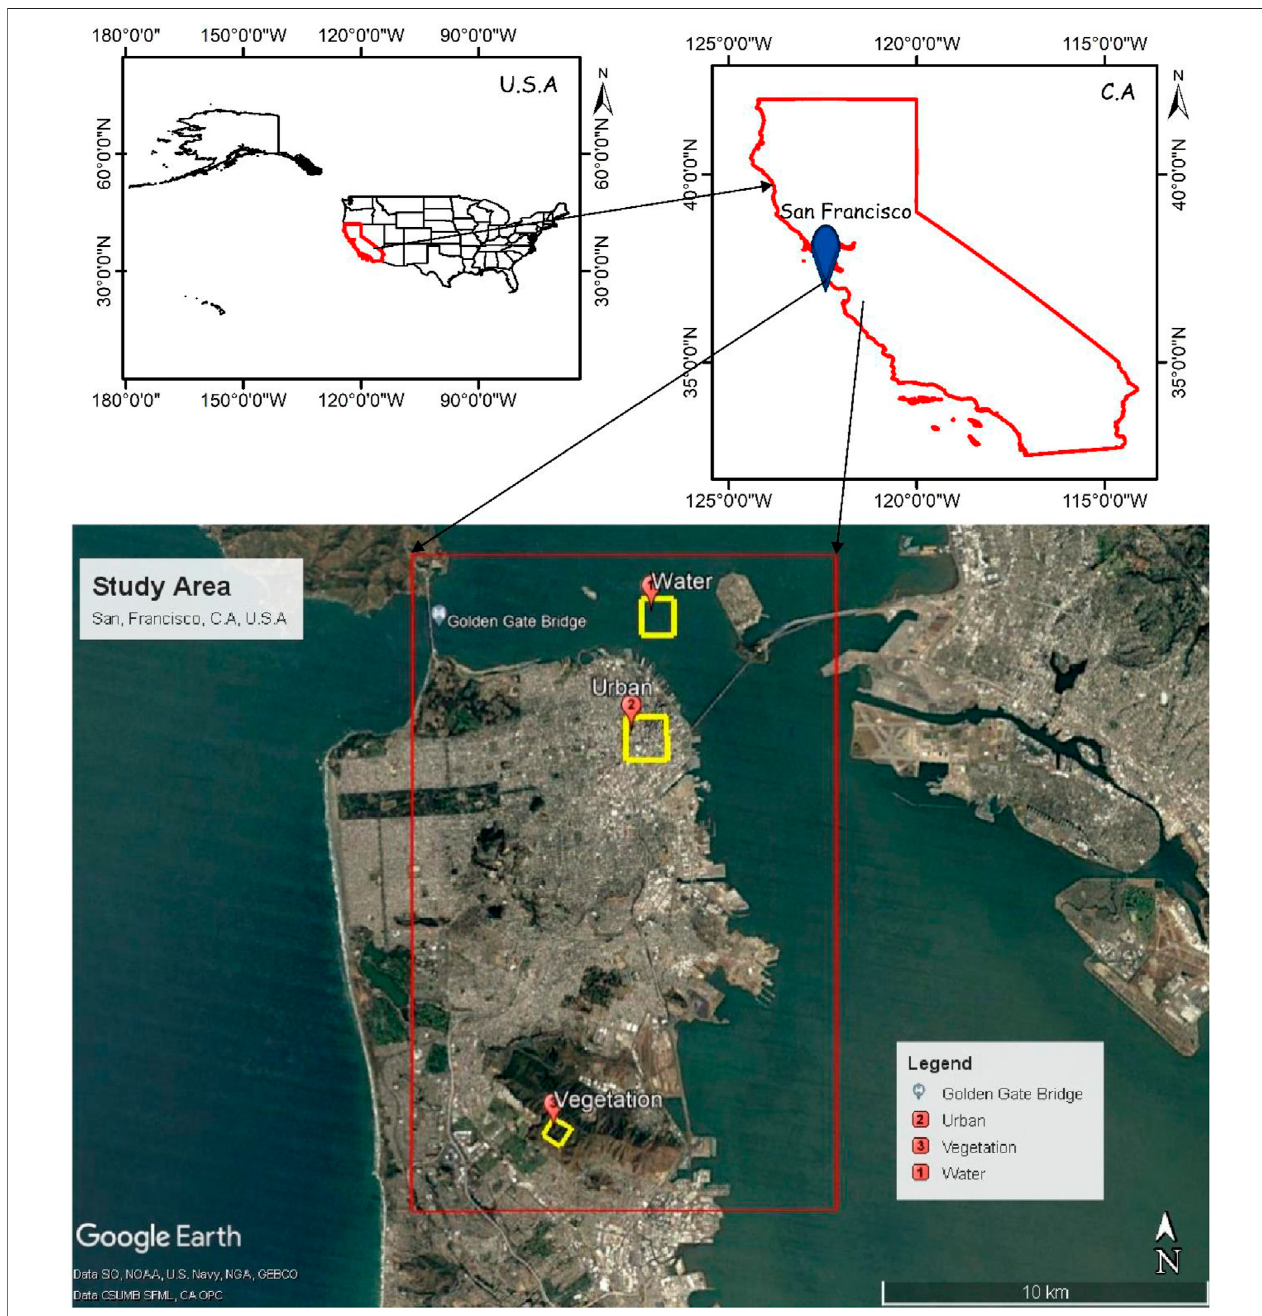
FIGURE 1 | Location of study area: San Francisco, CA, USA, on Google Earth Image (historical optical imagery: April 9, 2008); subset of study area (red line); location of water, urban, and vegetation regions.